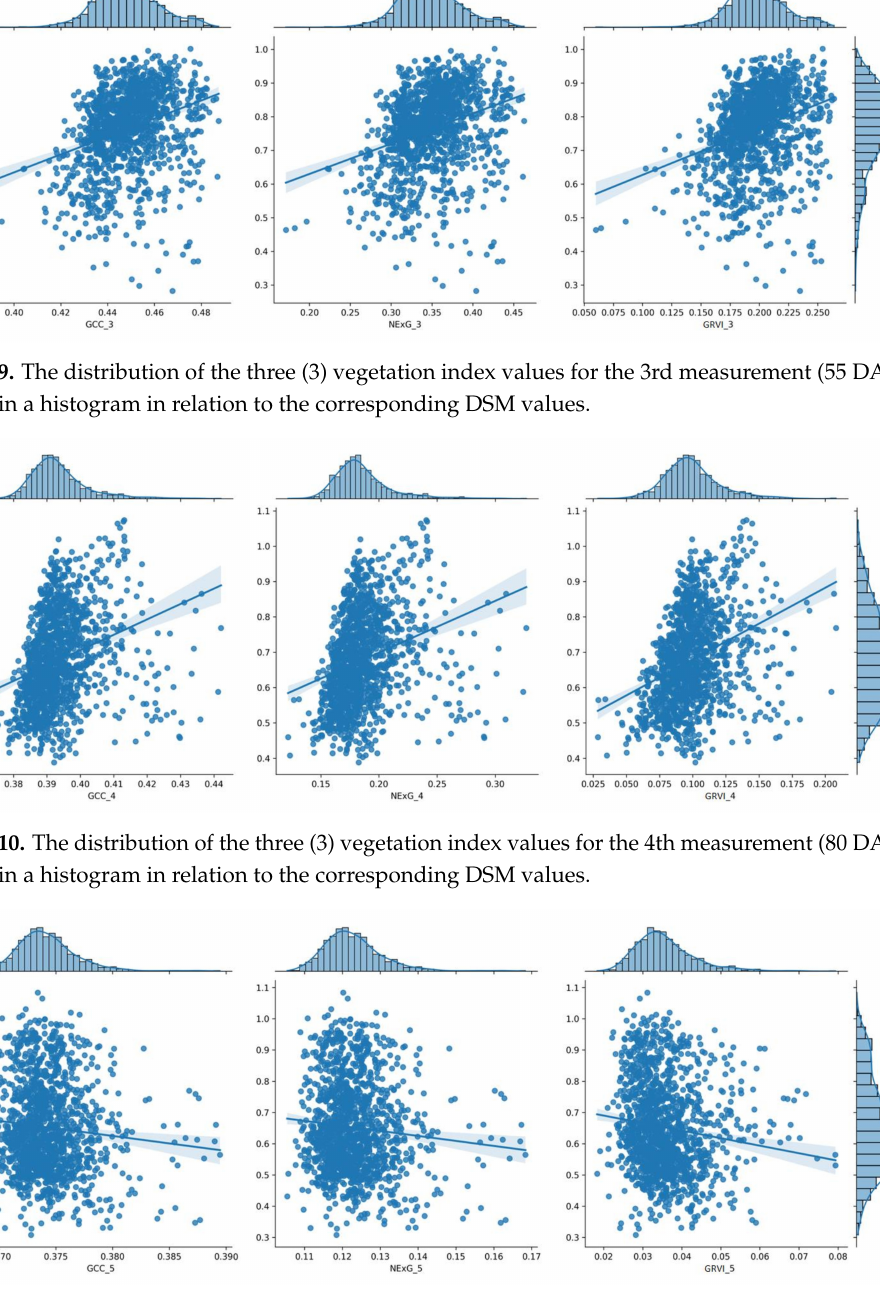
Figure 11. The distribution of the three (3) vegetation index values for the 5th measurement (110 DAS) shown in a histogram in relation to the corresponding DSM